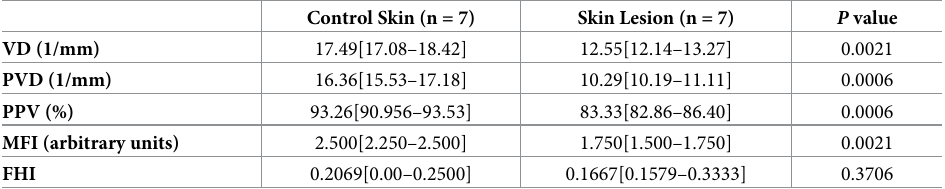
Table 3. Comparison between cutaneous microcirculation of healthy contralateral (control) skin and skin lesions of tuberculoid leprosy patients using sidestream dark field imaging.